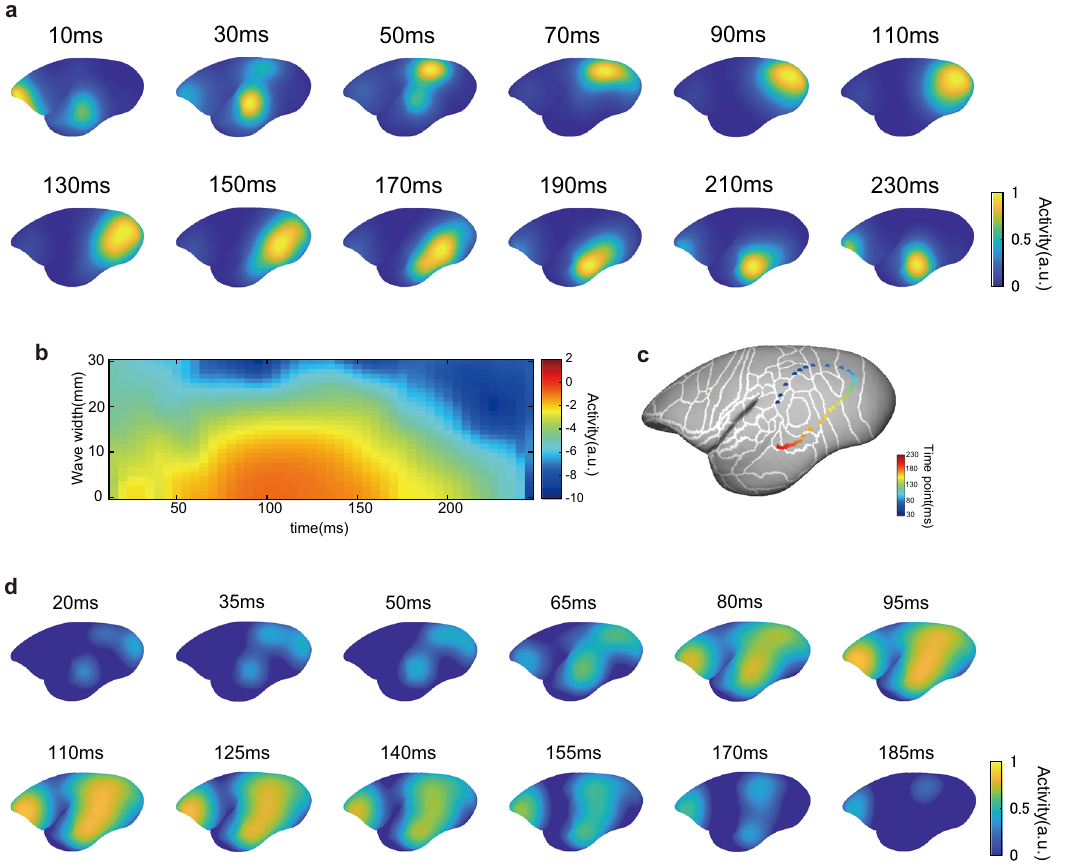
Fig. 6 Spatial – temporal dynamics of high-gamma signal uniquely to active vision. a Magnitude of the high-gamma signal in each time bin around saccades. Electrodes with a high-intensity signal were spatially clustered and moved across time. b High-gamma signal distribution across the cortical sheet as a function of distance from the center of high-gamma activity on the cortical surface in each time point. The high-gamma signal was spatially localized. c Center of gravity of the high-gamma signal. Colors represent the time from the saccade. The high-gamma signal peak moved from the dorsal region to the ventral stream. d Signal dynamics evoked by passive visual stimulus onset. In contrast to active vision, the initial response emerged at the most posterior part of the occipital regions and dSTS and this expanded toward the temporal and parietal cortices, which correspond to the ventral and dorsal stream,